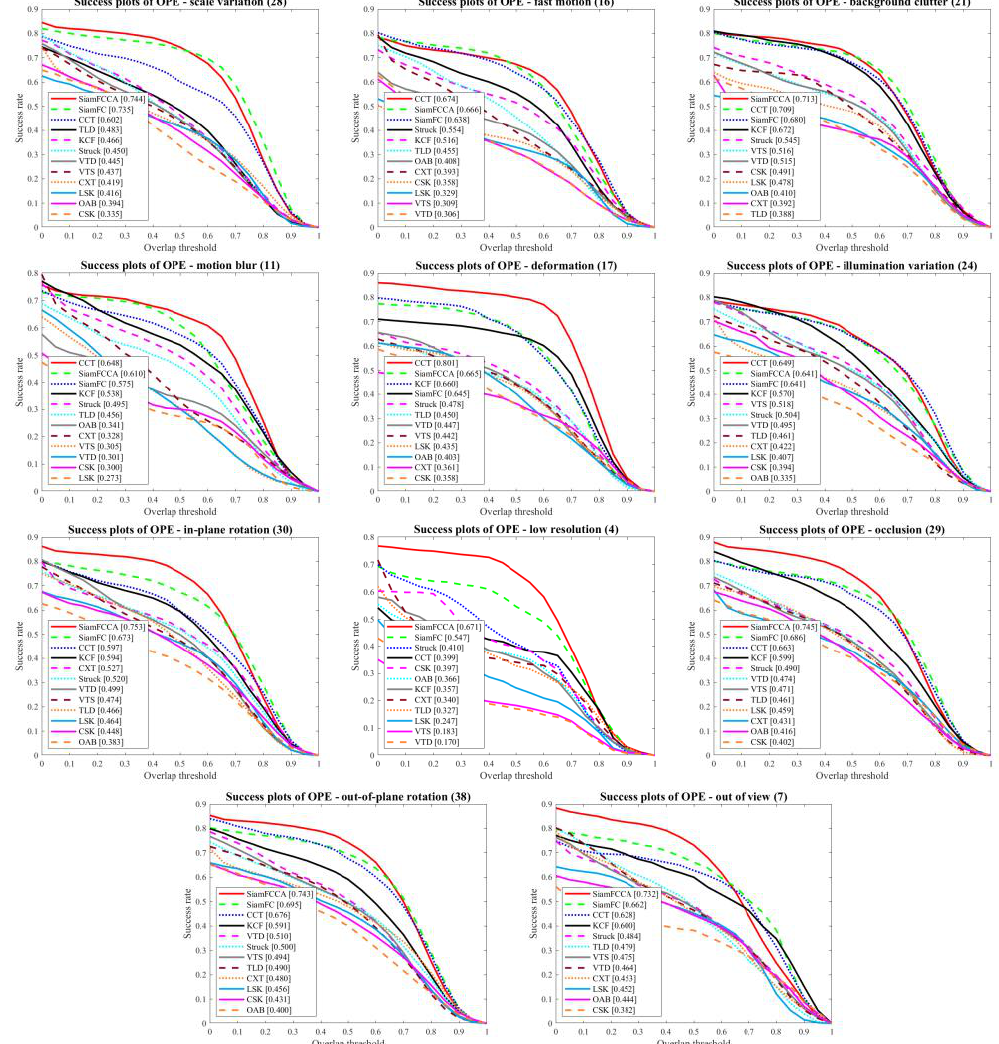
Figure 13. The success maps of the proposed SiamFCCA and other tracking methods for each sub-category.